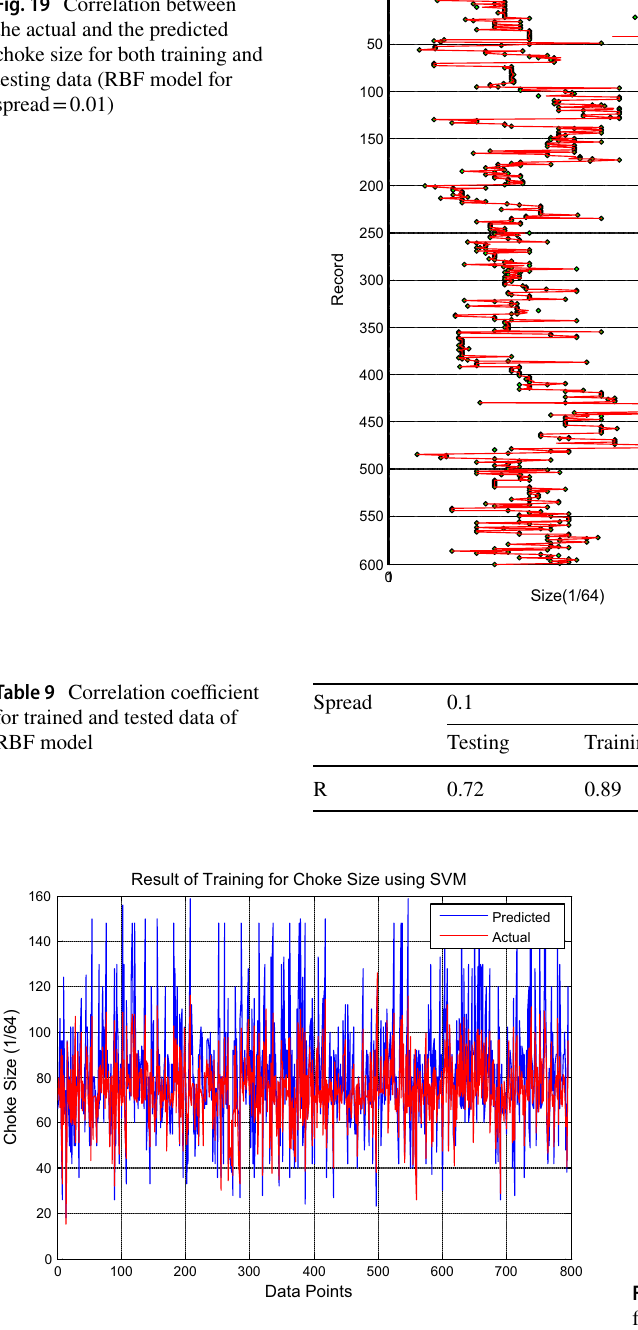
Fig. 20 Correlation between the actual and the predicted choke size for training data (Poly function) ( R = 0.82)